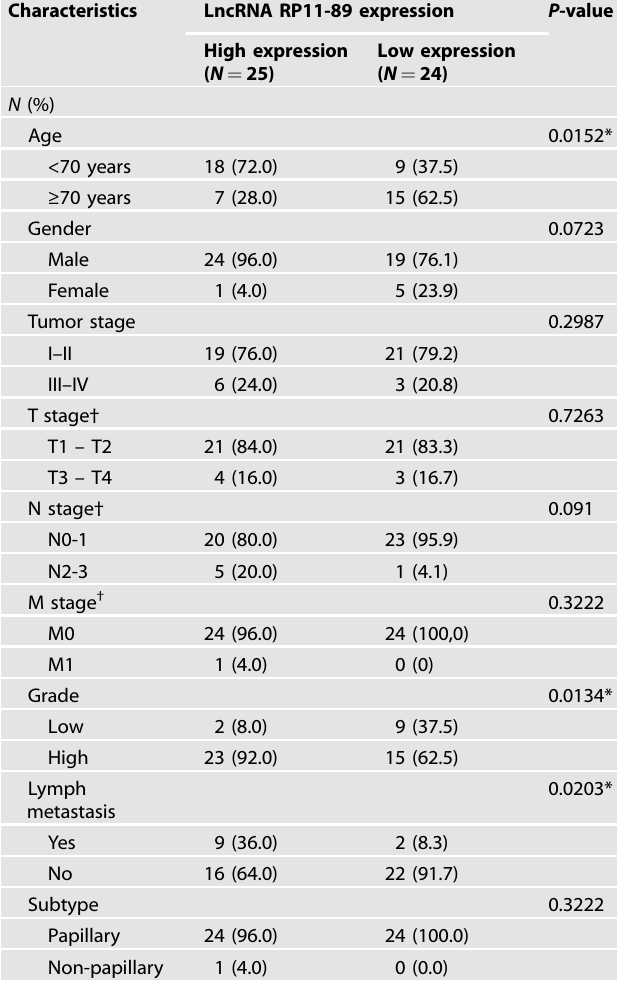
Table 1. Correlation between clinicopathological characteristics of 49 BLCA patients and RP11-89 expression level in FUSCC